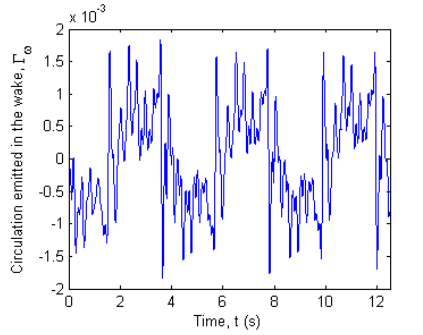
Fig. 12. Circulation emitted in the wake at each time step.